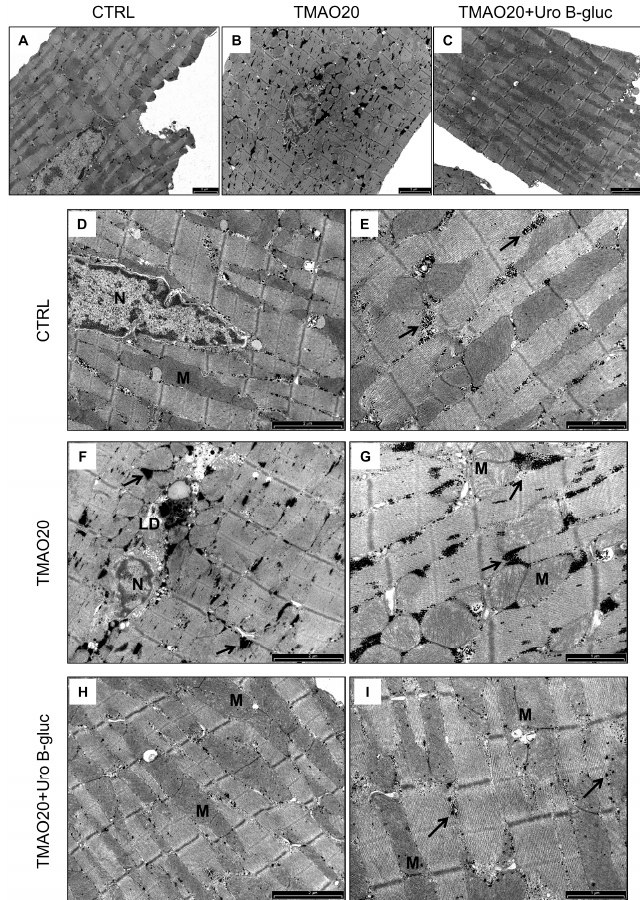
Figure 3. Effects of TMAO and TMAO + Uro B-gluc on cardiomyocyte ultrastructure (TEM study).